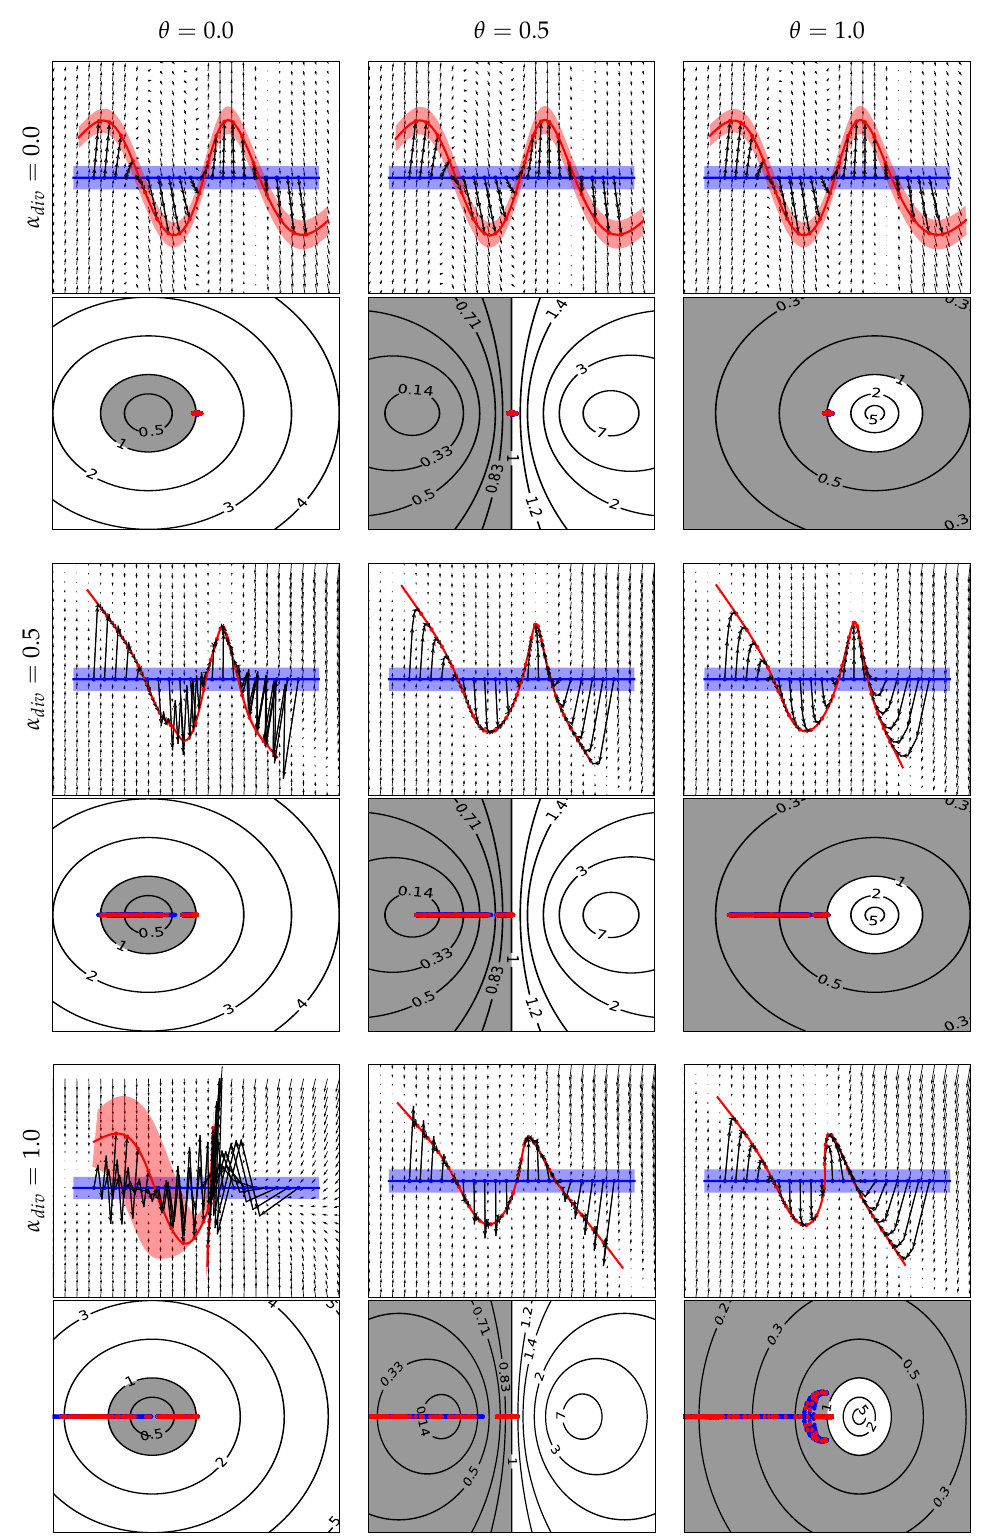
Figure 8. (Top) Learned vector fields F ( γ , y ) in Example 1. Blue line is the initial state, red curve is the final state after T = 5 steps, solid black lines are the trajectories of the training data. ( Bottom ) Eigenvalues of ∂ F ( γ , y ) ∂ y evaluated along the learned trajectories at times t = 0,..., T . Red and blue dots are used for the train and test datasets, respectively. Stability regions of implicit layers are highlighted with grey color and the contours depict the values of the stability function.